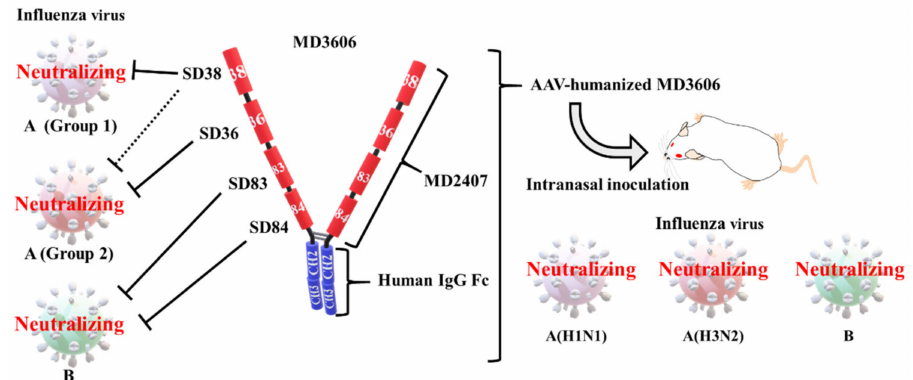
Figure 3. Cross-protection with a heavy chain only antibody (V H H)–Fc fusion construct. All four V H Hs were obtained by immunizing llamas with recombinant hemagglutinin (HA). V H H (SD38) can neutralize group 1 influenza A viruses and weakly neutralize some group 2 viruses, V H H (SD36) neutralizes group 2 influenza A viruses, and V H H (SD83 and SD84) neutralizes influenza B viruses [8]. A tetravalent multidomain antibody (MDAb; MD2407) was generated by connecting V H Hs with (GGGGS) 2 -linkers. An MDAb–Fc fusion (MD3606) was generated by attaching MD2407 to the human IgG Fc region. MD2407 and MD3606 neutralized influenza A and B viruses in vitro. Intranasal